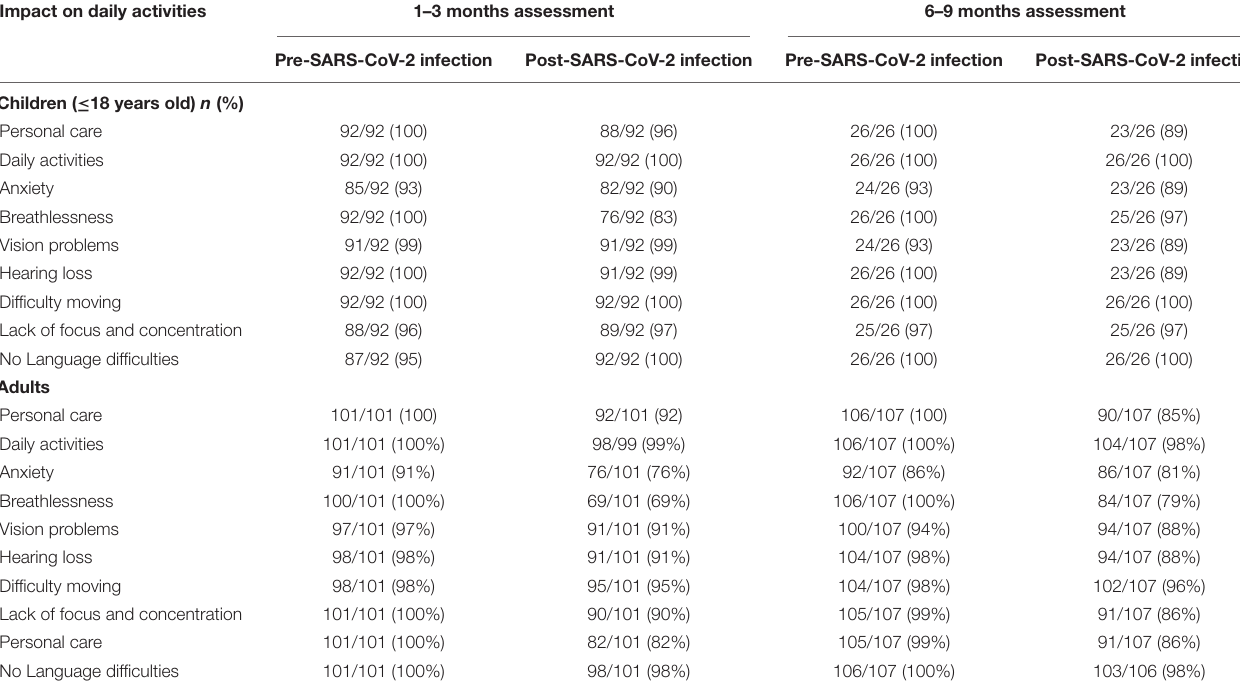
TABLE 7 | Changes in wellbeing and impact on daily activities among children with confirmed SARS-CoV-2 infection compared with before infection. Impact on daily